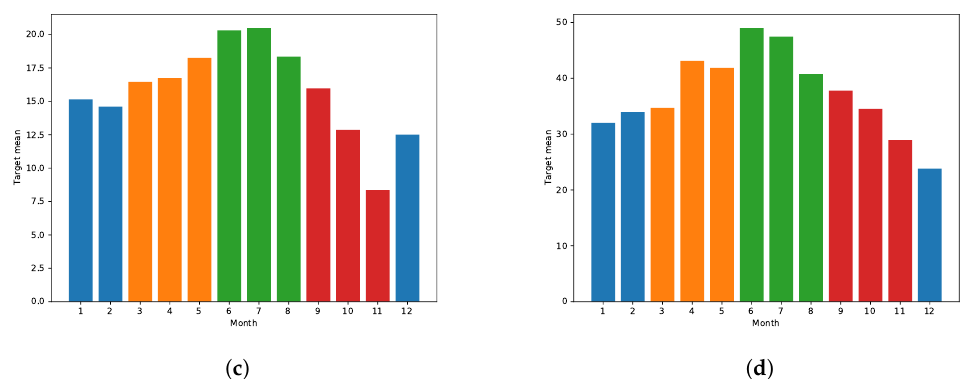
Figure 1. Hourly photovoltaic energy mean in majorca ( a ) and tenerife ( b ) measured in MWh. Photovoltaic energy monthly averages for majorca ( c ) and tenerife ( d ), colored using the tasks defined using the season and measured in MWh. All the histograms have been computed using data from year